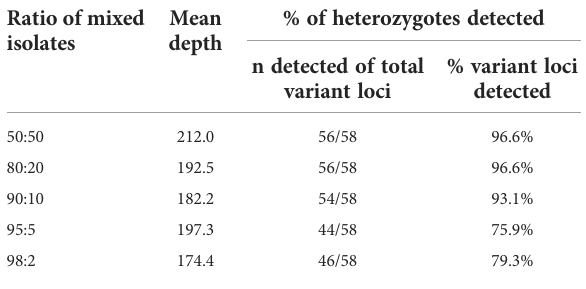
TABLE 4 Detection of an arti fi cially created mixed clone infection of two previously genotyped samples from the same period and area in